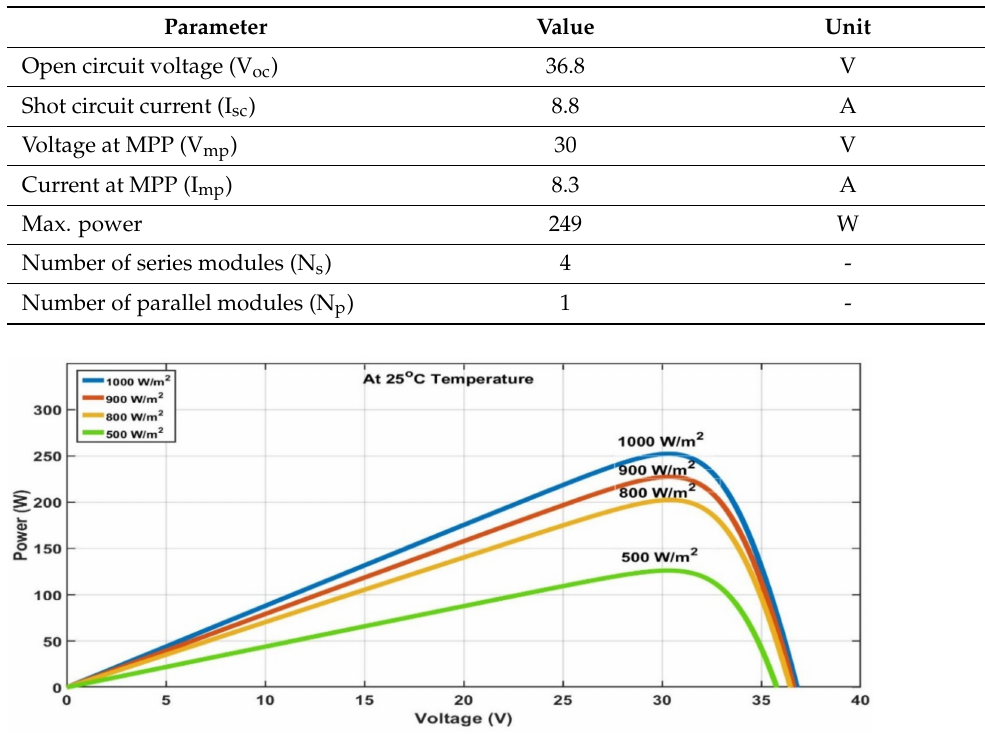
Figure 8. P-V curves with different irradiances at 25 ◦